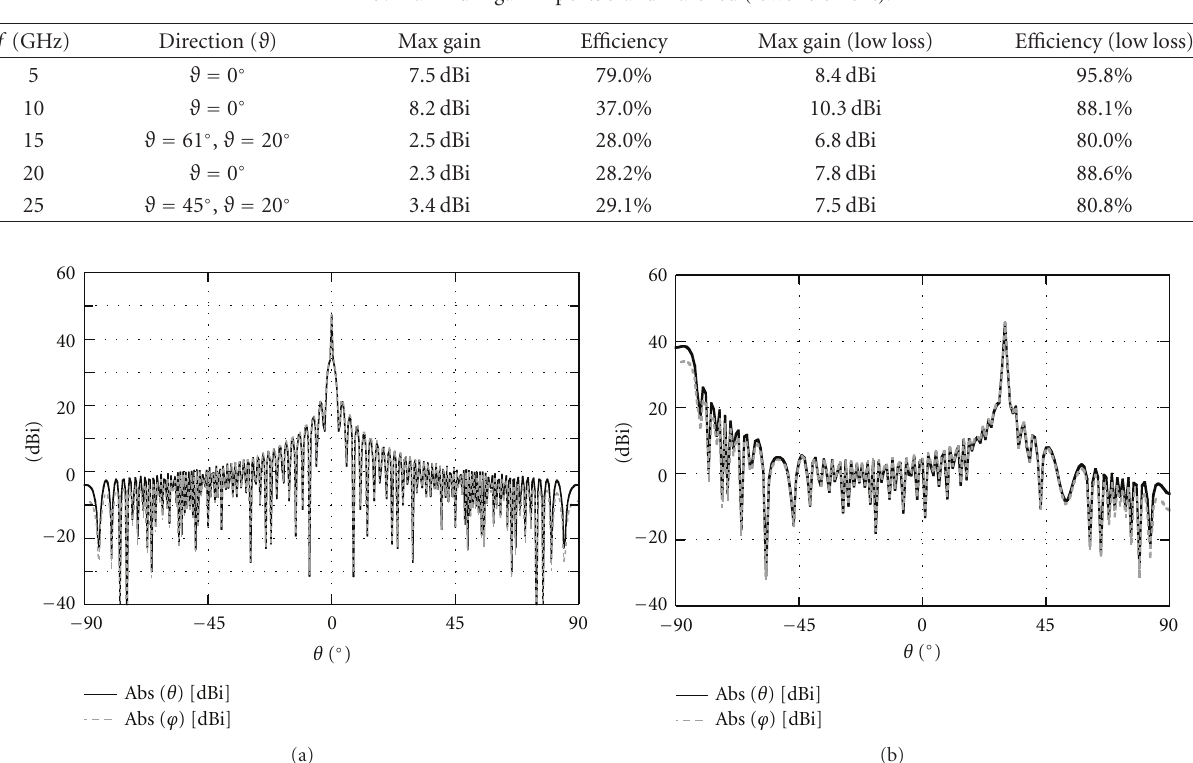
Table 3: Maximum gain if ports 3 and 4 are fed (lower element).